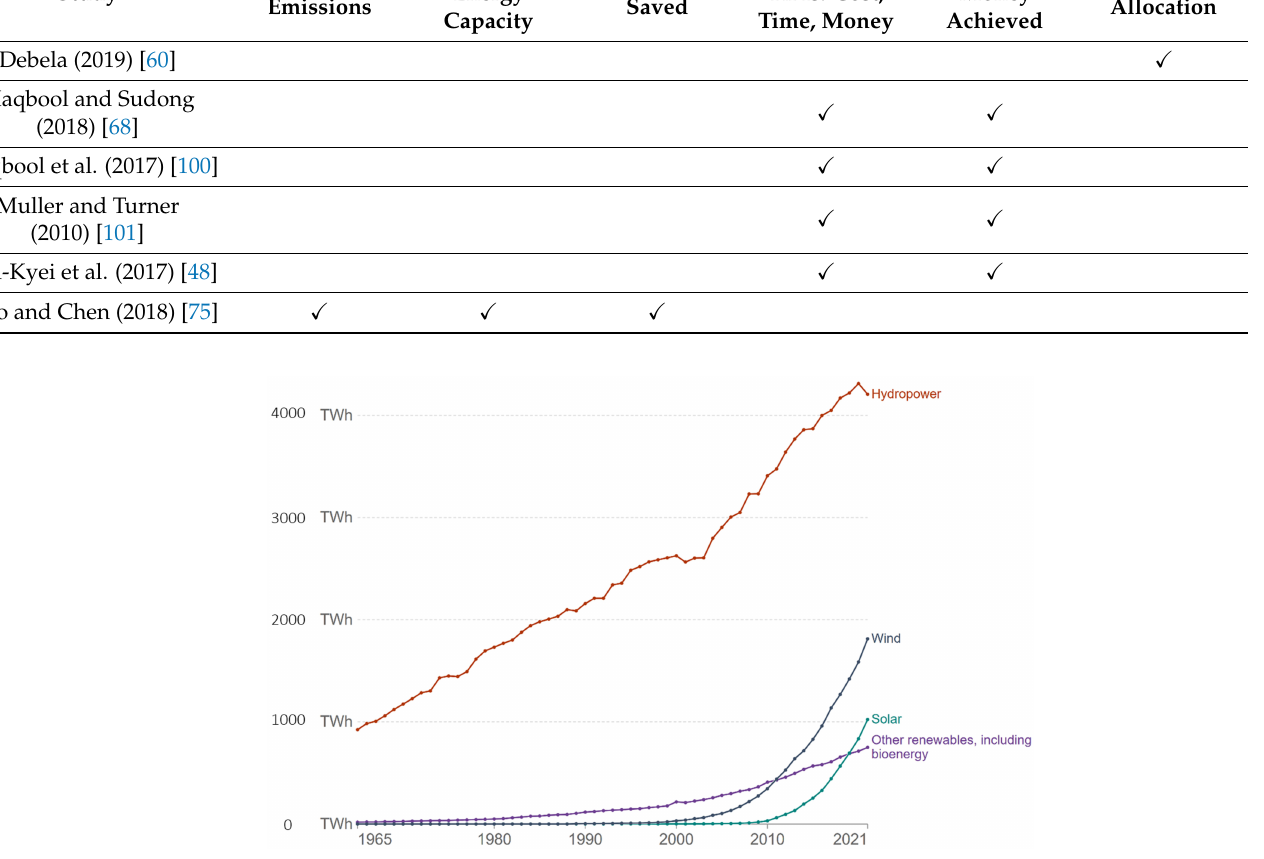
Figure A1. Total renewable-energy generation by source across the years.